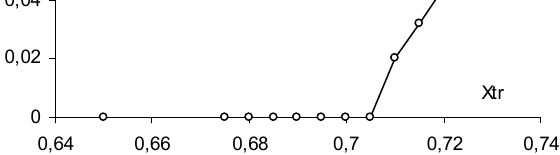
Fig 5. Calculated (MSES) length of laminar separation bubble on the upper side of airfoil 1 versus forced transition location at a = 0